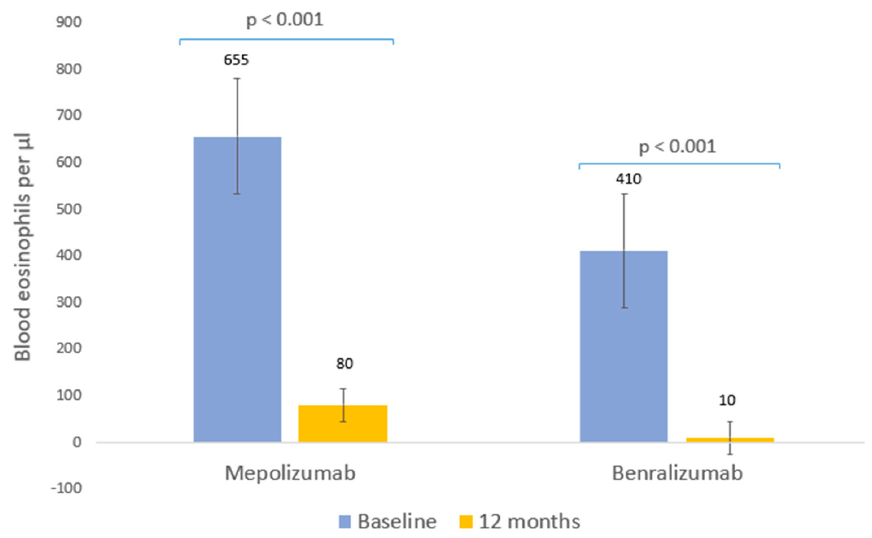
Figure 4. Clinical response to biological therapies: blood eosinophils. Median eosinophils prior to biological therapy and after 12 months of treatment. Table 4. Clinical effectiveness of mepolizumab in patients with severe uncontrolled